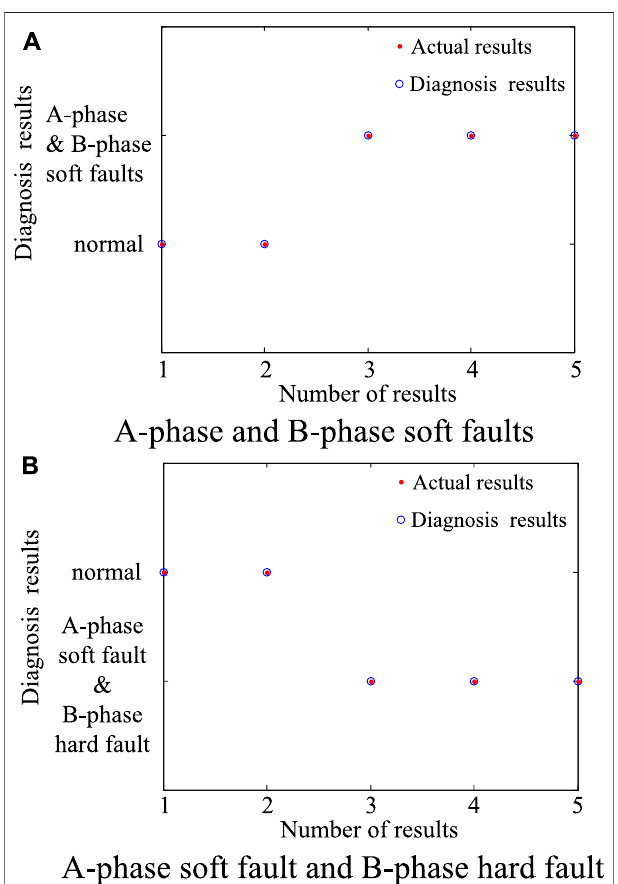
FIGURE 15 | Fault diagnosis results with multiple current sensor